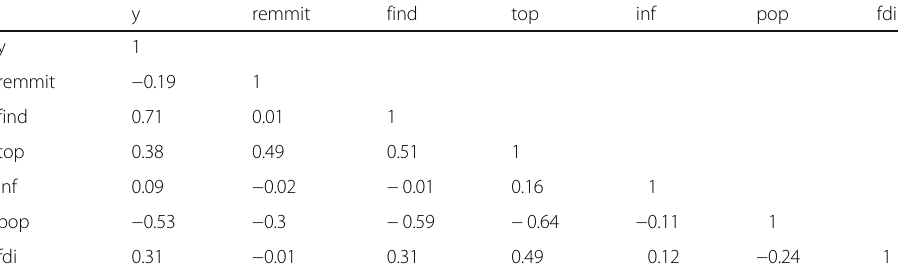
Table 5 Correlation Matrix of the selected